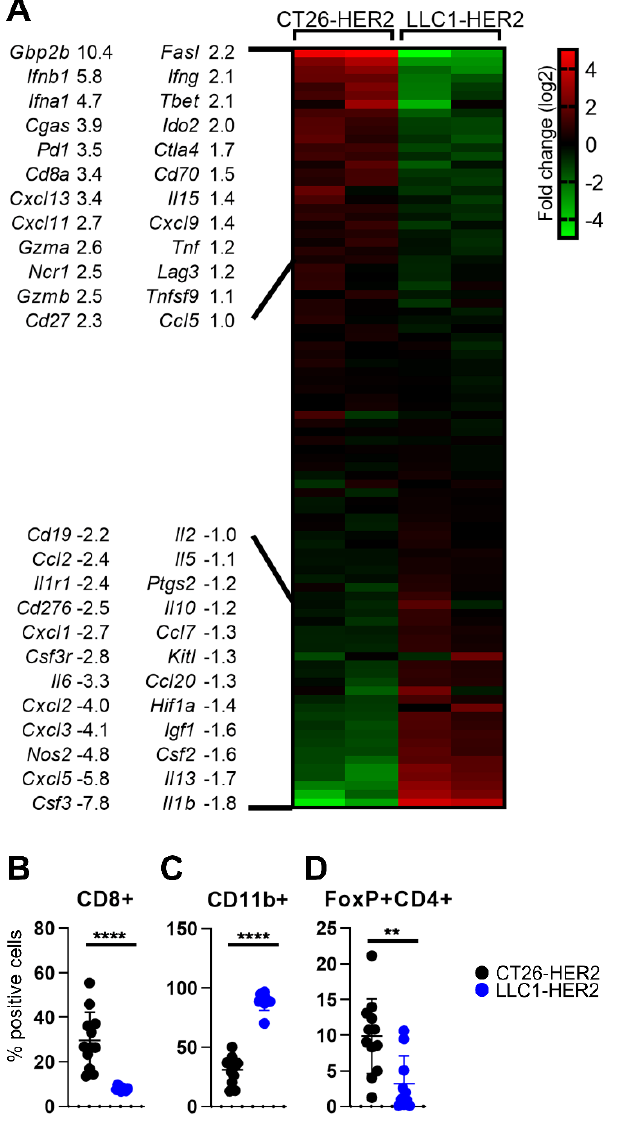
Figure 2. Immune profile of CT26-HER2 and LLC1-HER2 tumors ( A ) Expression array. Few milligrams of CT26-HER2 and LLC1-HER2 tumor homogenates were employed for total RNA extraction. Purified RNAs were employed for the cDNAs synthesis. cDNAs were assayed by the real-time PCR array described in Table S1. The Ct values were normalized on the Rpl13a house-keeping gene and, for each gene, expression levels were calculated as log2 fold change values with respect to the average ΔCt value of the gene. Differentially expressed genes (log2 fold changes >|1|) and log2 fold change values are reported. ( B – D ) Immune cell populations in tumors. Single cell suspensions were prepared from freshly isolated CT26-HER2 and LLC1-HER2 tumors at sacrifice. Tumors were minced in small pieces, digested with collagenase, passed through 70 μm cell strainer, and rinsed with FACS buffer. For each sample, 2 × 10 6 cells were blocked with α -CD16/32 Ab (clone 93) and then reacted with the antibodies: CD8a-PE (clone 53-6.7), CD45-Percp-Cy7 (clone 30-F11), FoxP3-PE (clone 150d/e4), and CD11b-FITC (clone M1/70). Data were acquired on BD C6 Accuri. CD8 (CD8+ cells) and myeloid cells (CD11b+ cells) were gated on CD45+ subpopulation. Tregs (FoxP3+ CD4+) were gated on CD4+ population. ( B – D ) Statistical significance was calculated by the t -test and expressed as ** = p value < 0.01; **** = p value < 0.0001. Color codes: mice engrafted with CT26-HER2 (black) or LLC1-HER2 (blue).